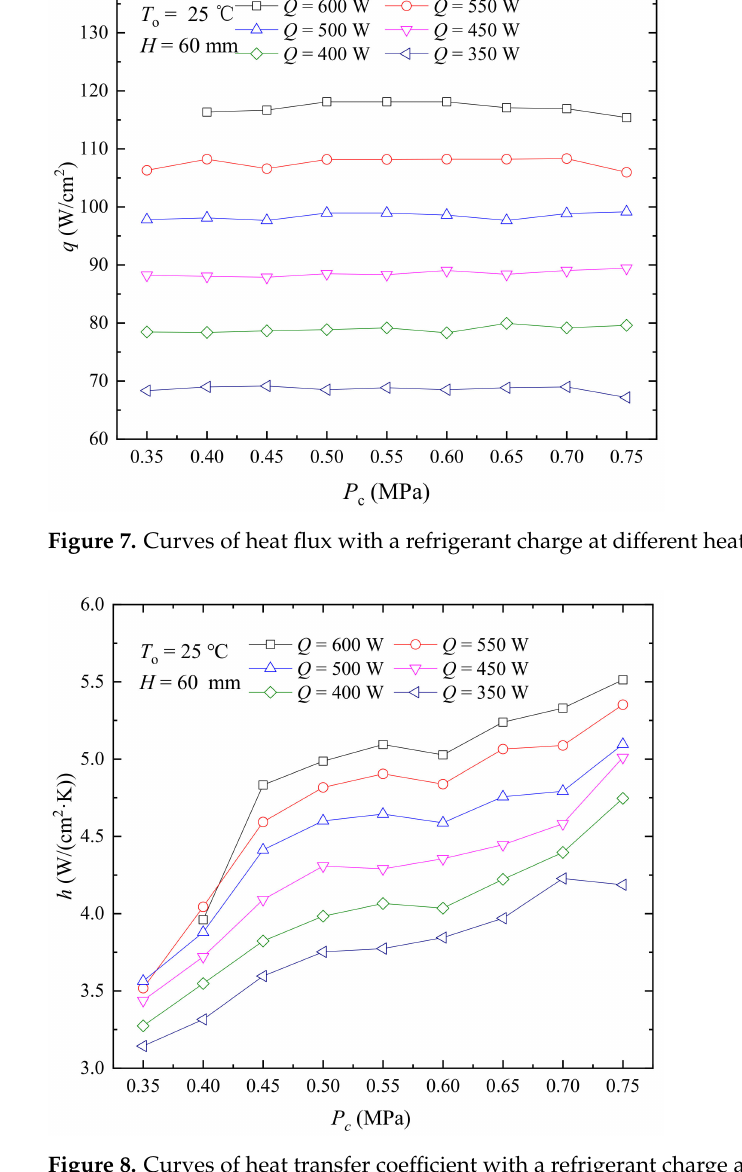
Figure 8. Curves of heat transfer coefficient with a refrigerant charge at different heating